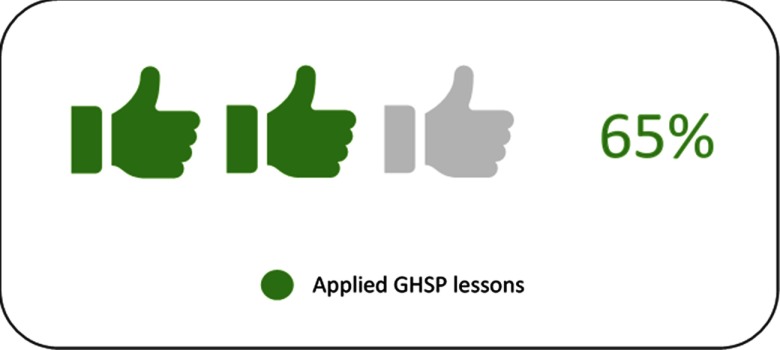
Use of GHSP Lessons by ReadersSource: 2017 GHSP reader survey.